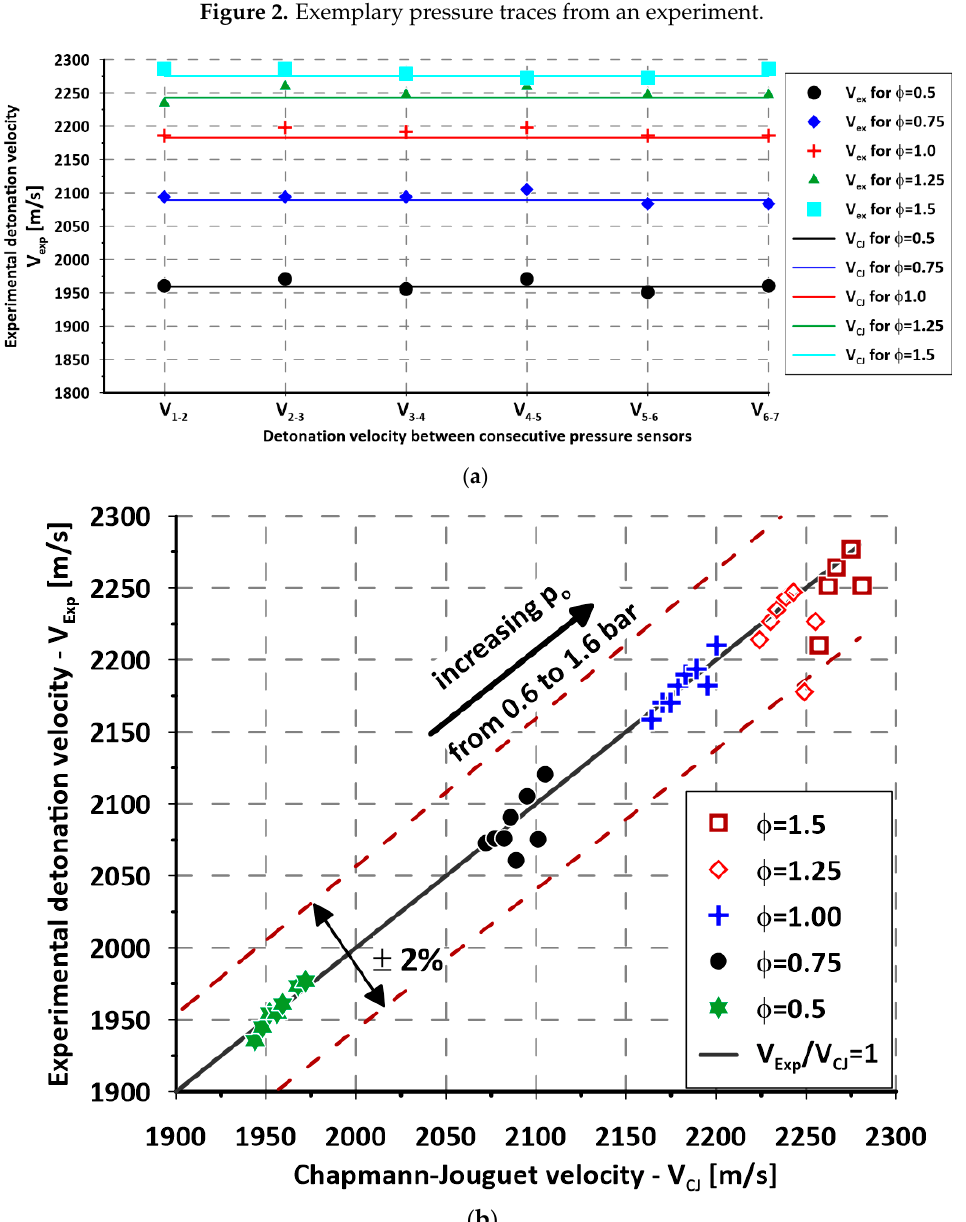
Figure 3. A comparison of detonation velocity from the experiments V Exp and theoretical V CJ : ( a ) detonation velocity calculated between consecutive pressure sensors, initial pressure p 0 = 1 bar; ( b ) average detonation velocity from all the cases compared to theoretical Chapman—Jouguet detonation velocity V CJ .